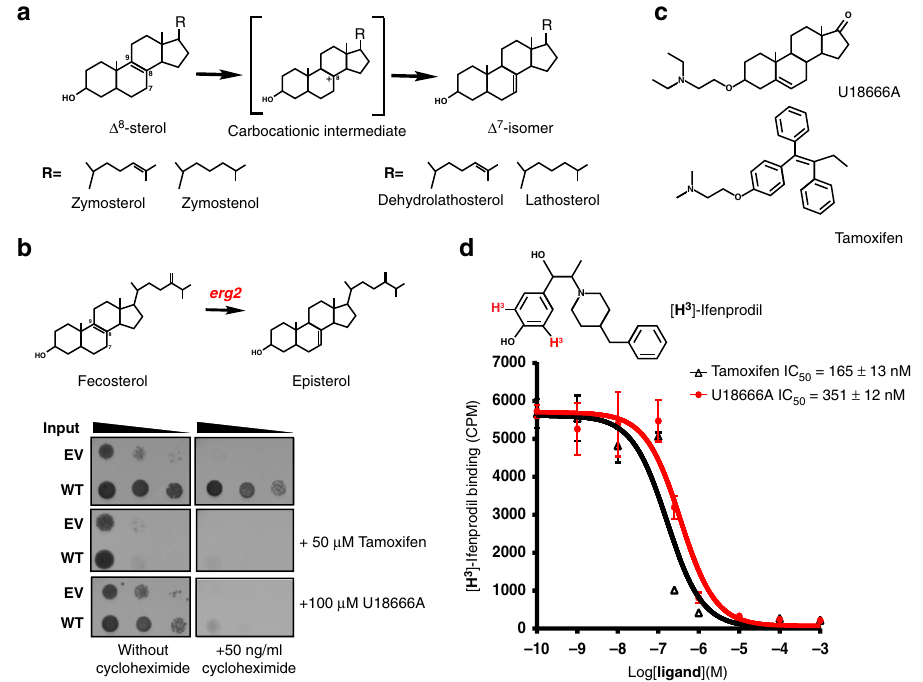
Fig. 1 Functional characterization of human EBP protein. a Reaction catalyzed by human EBP in which zymosterol ( Δ 8 -sterol) is converted to dehydrolathosterol ( Δ 7 -sterol). b Yeast complementation assay. EBP can rescue the growth of a Saccharomyces cerevisiae sterol isomerase Erg2 (yeast EBP homologue) deletion strain ( Δ Erg2). Growth of yeast expressing human EBP in the presence of sub-inhibitory concentrations of cycloheximide for 24 to 48 h with or without pharmacological compound. c The structures of U18666A and tamoxifen. d The binding of EBP to different ligands. Inhibition of [ 3 H]- Ifenprodil binding to the puri fi ed EBP protein by U18666A (red) and tamoxifen (black). Data shown are the mean ± SD of three determinations. Source data are provided as a Source Data fi le. EV empty vector, WT wild